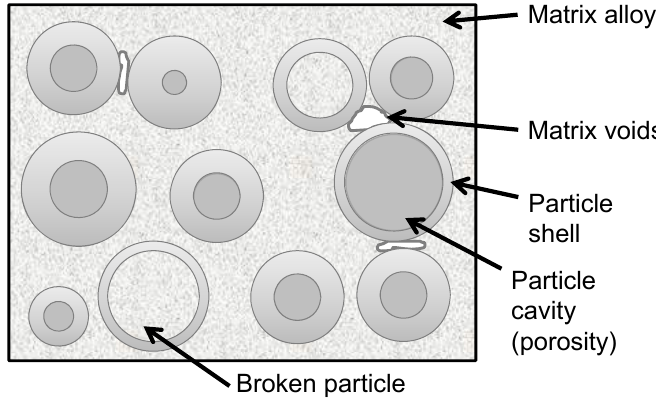
Figure 1. Schematic illustration of syntactic foam microstructure showing various phases and two types of